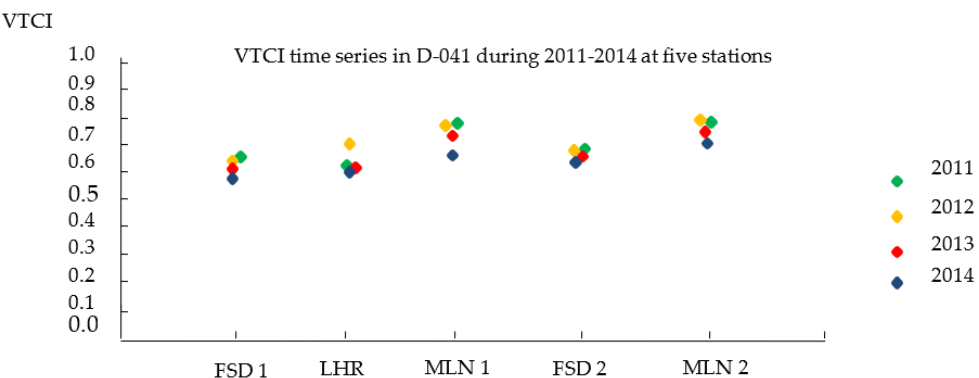
Figure 4. VTCI values for each of five meteorological stations in the D-041 period during 2011–2014 per pixel area of Punjab, based on the VTCI drought categorization. The presented VTCI categorization uses the following scales: wet to dry or 0 to 1; normality or wetness (1.0 to 0.57); and slightly mild (0.57 to 0.44), moderate (0.44 to 0.38), and severe (0.38 to 0.0) drought. The VTCI values in the first 16 days of Feb. (D-041) from 2011 to 2014 at five meteorological weather stations show the normality (0.586492375 – 0.775163399). The VTCI values at MLN 1 and MLN 2 present high values, whereas, FSD 1 and FDS 2 and the LHR have low VTCI values in the D-041 period. This shows that the area is not only rainfed but irrigated .